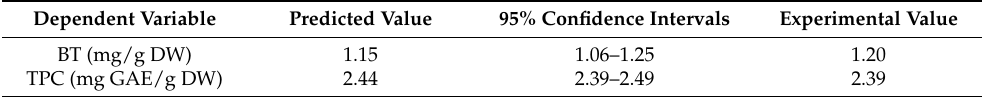
Table 4. Validation of the mathematical